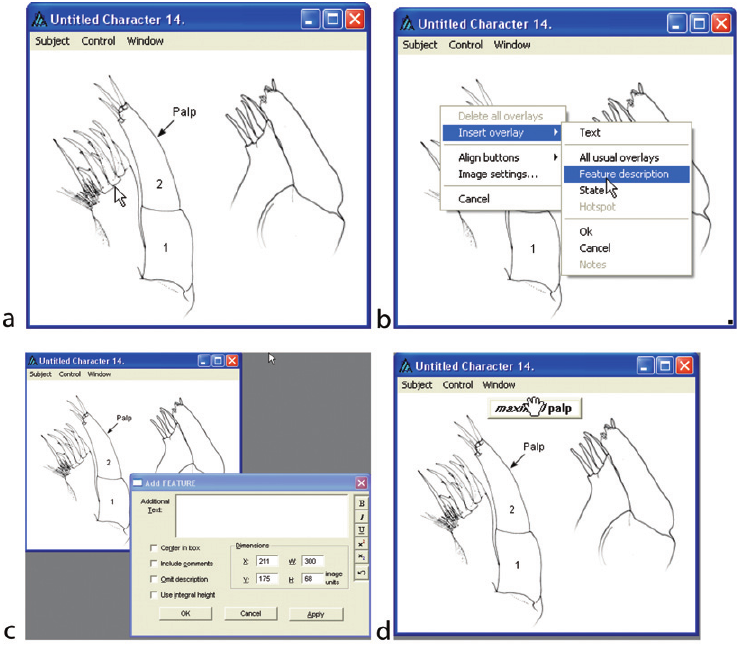
Figure 18a–d. Inserting an overlay with the feature text description on a character illustration.